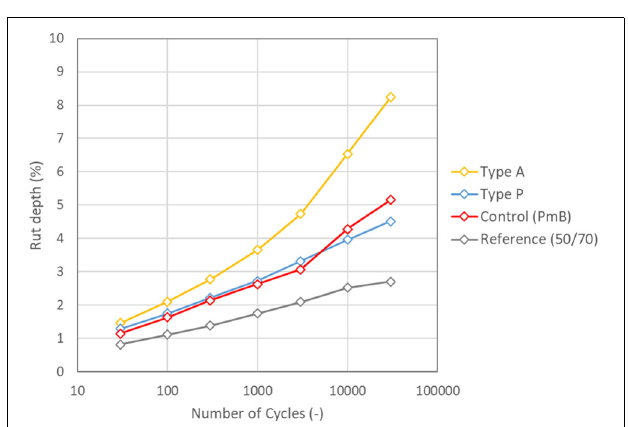
FIGURE 7 | Rutting (wheel tracking) testing results for different